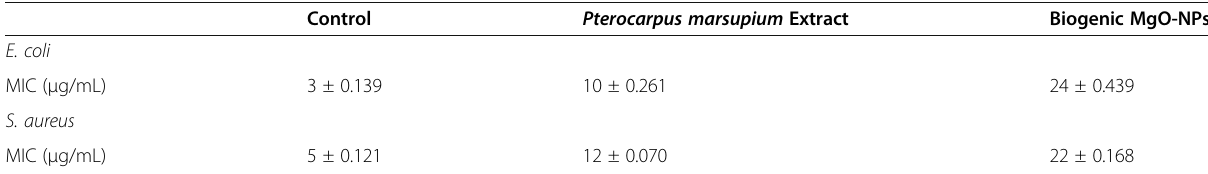
Table 2 Minimum Inhibitory Concentration values of MgO-NPs synthesized from P . marsupium heartwood extract against E . coli and